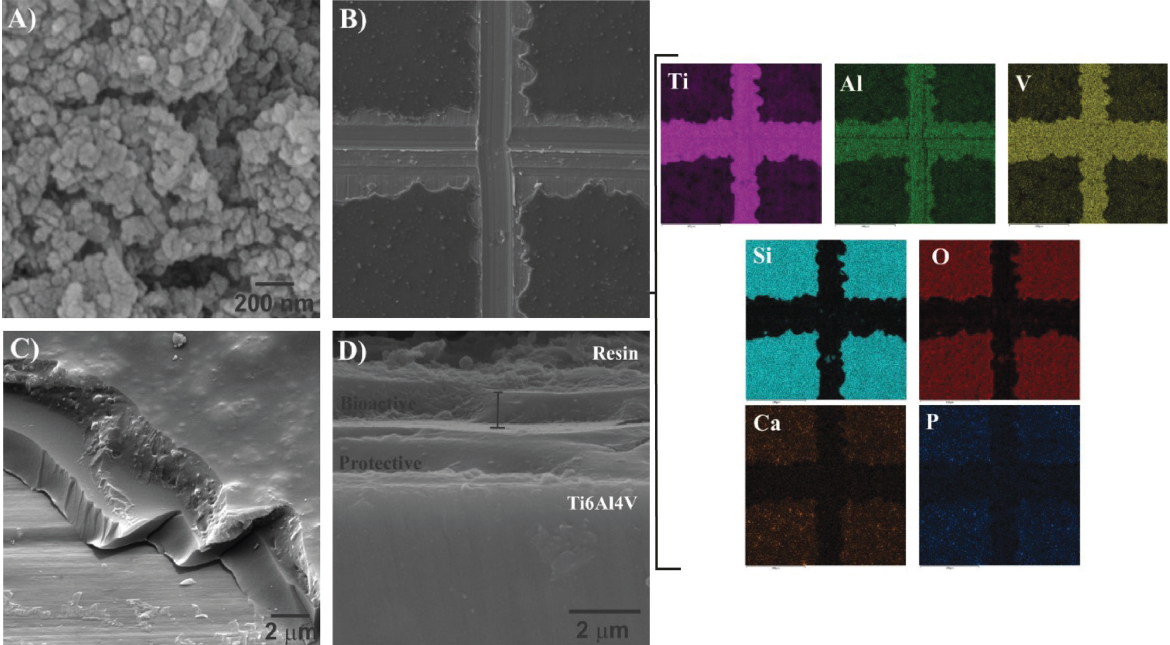
Figure 3: SEM/FEG micrographs (A) of the hydroxyapatite particles and the hybrid coating cured at 60 ° C in different analyzed areas, (B) after the adhesion assay with elemental mapping according to the coating composition, (C) of the detachment region with slope of 35 ° , and (D) of the transverse view of deposited